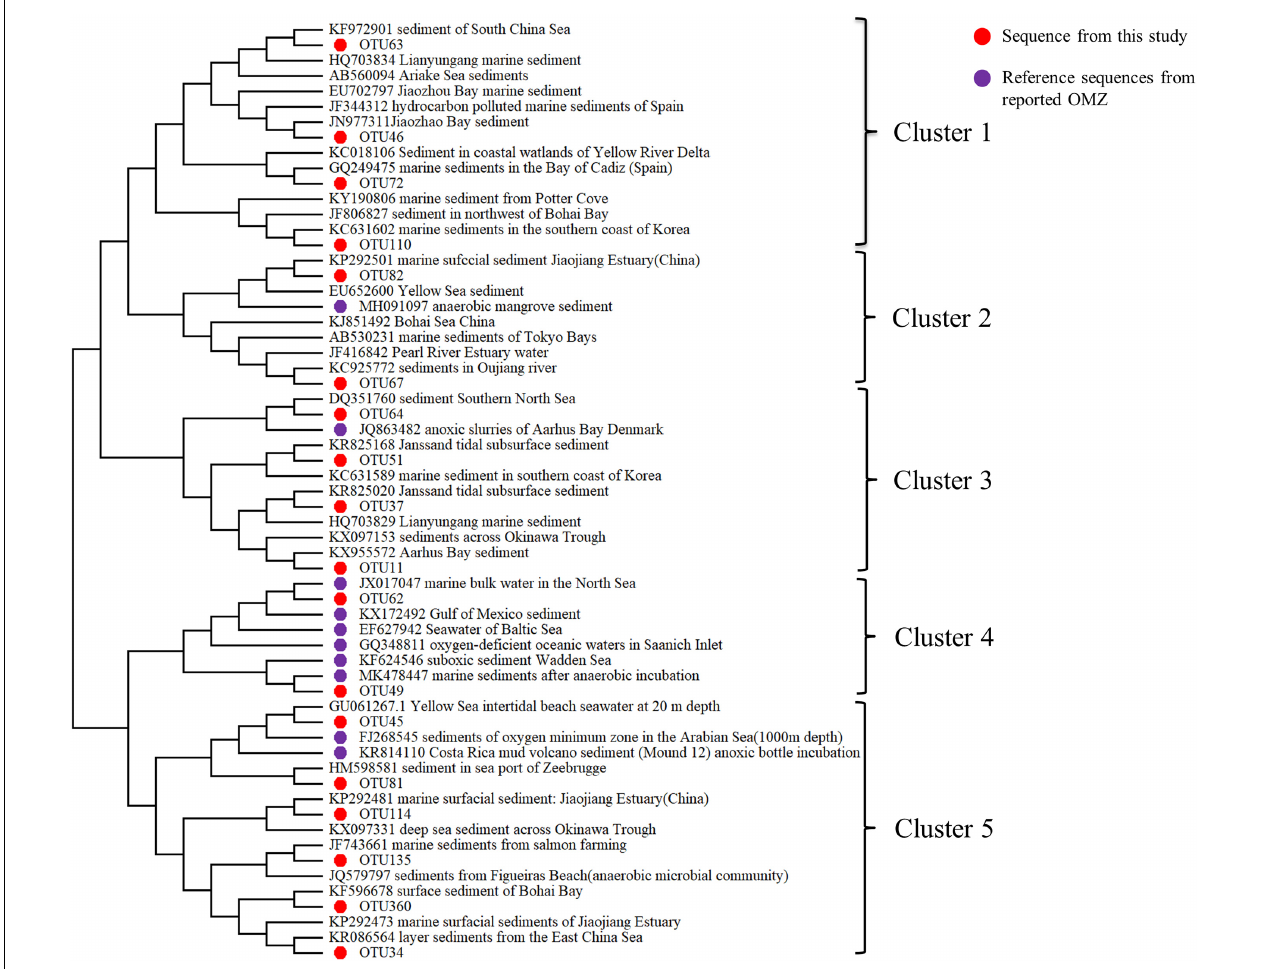
FIGURE 6 | Neighbor-joining phylogenetic tree of the dominant OTUs (Top 18) in the sediment samples of Bohai Sea (Bootstrap values were 1,000 replicates).